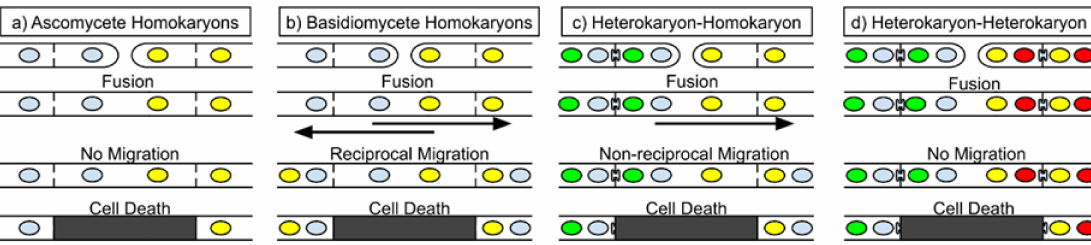
Figure 2. Nuclear migration permits mating in basidiomycetes despite the death of fusion cells. ( a ) The left panel shows the conventional ascomycete scenario, the fusion and subsequent cell death between two genetically different homokaryons; ( b ) shows the basidiomycete scenario when two different homokaryons meet and fuse, it generally leads to mating and reciprocal nuclear migration even though the fusion cell may die; ( c ) shows the outcome of a Buller mating, with unidirectional nuclear migration into the homokaryon individual, producing two different heterokaryons separated by a now-dead fusion cell; ( d ) When two distinct heterokaryons fuse, for example, mated basidiomycetes, it leads to nonself recognition and cell death like the others, but the lack of nuclear migration means that no further matings are produced. The scenario in ( d ) also applies for pseudohomothallic ascomycetes such as Neurospora tetrasperma or Podospora anserina